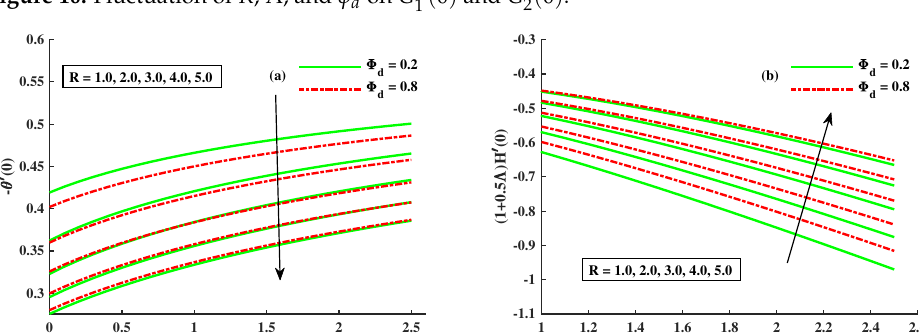
Figure 10. Fluctuation of R , Λ , and φ d on G (cid:48)(cid:48)